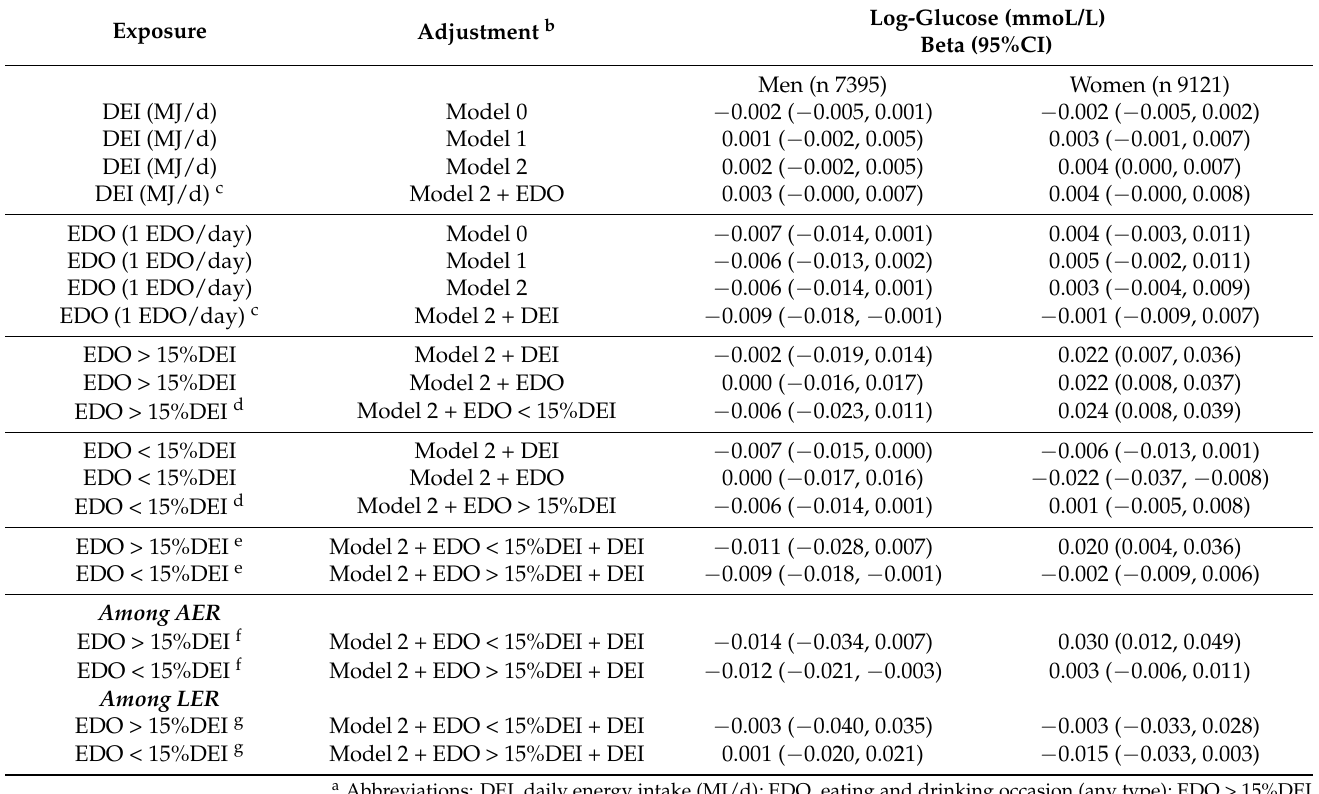
Table 2. Association between DEI and/or EDO frequency and glucose concentrations a